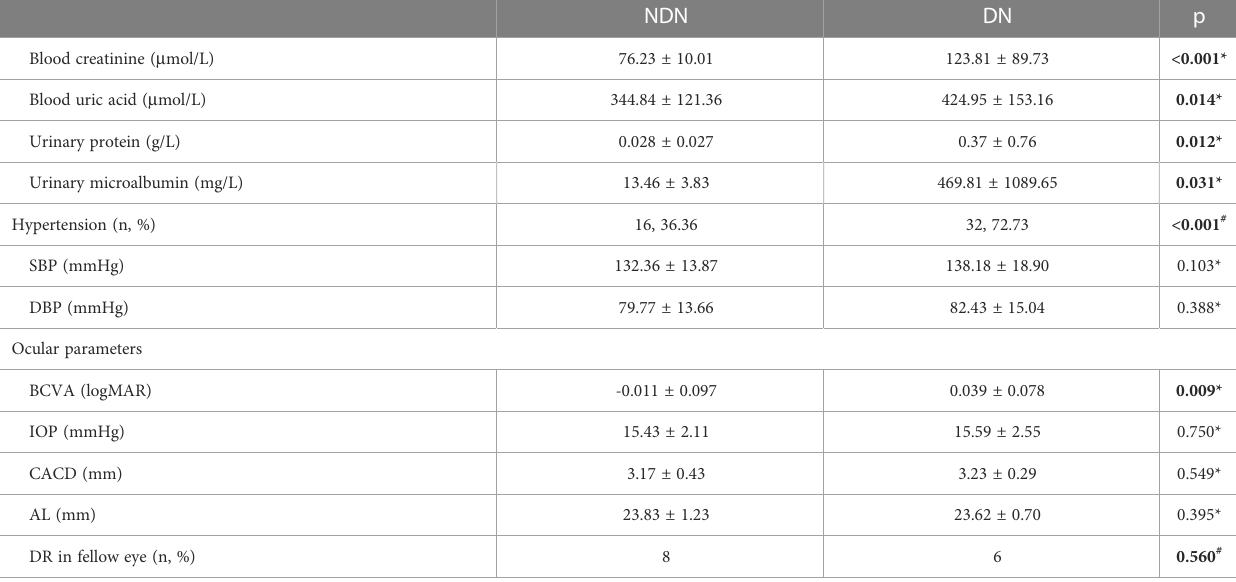
whereas there was no relationship between the level of the remaining renal function parameters (blood urea, blood creatinine, blood uric acid, urinary protein and urinary microalbumin) and OCTA parameters. Relationships between the level of eGFR and each representative OCTA parameter are shown